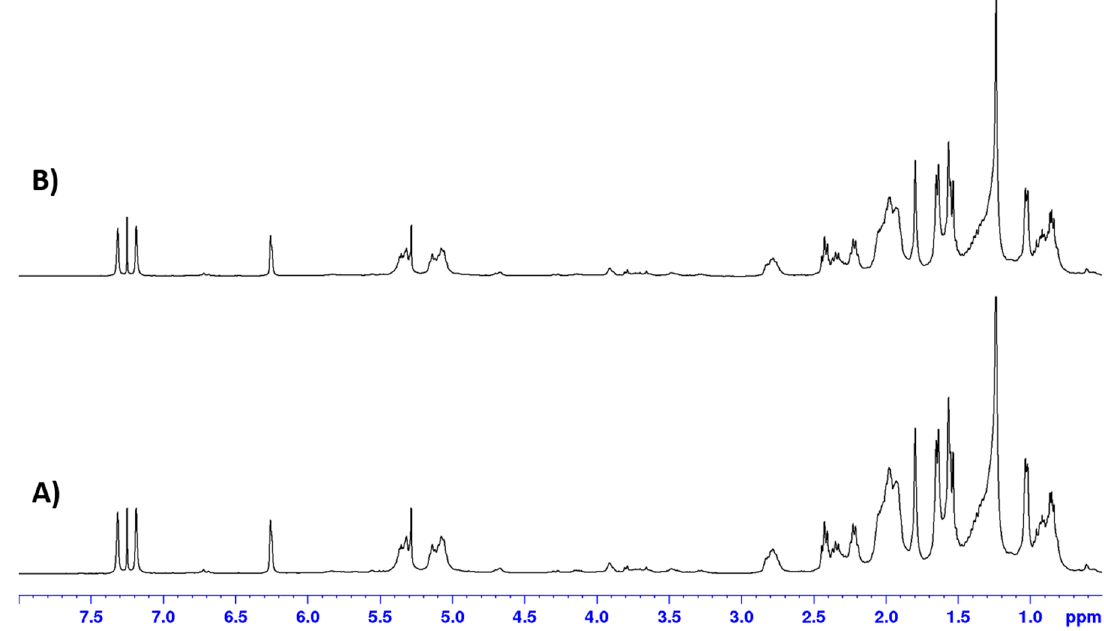
Figure 5. 1 H NMR spectra (CDCl 3 , 400 MHz) for the Var-SLNs immediately after purification ( A ), and one week later ( B ).